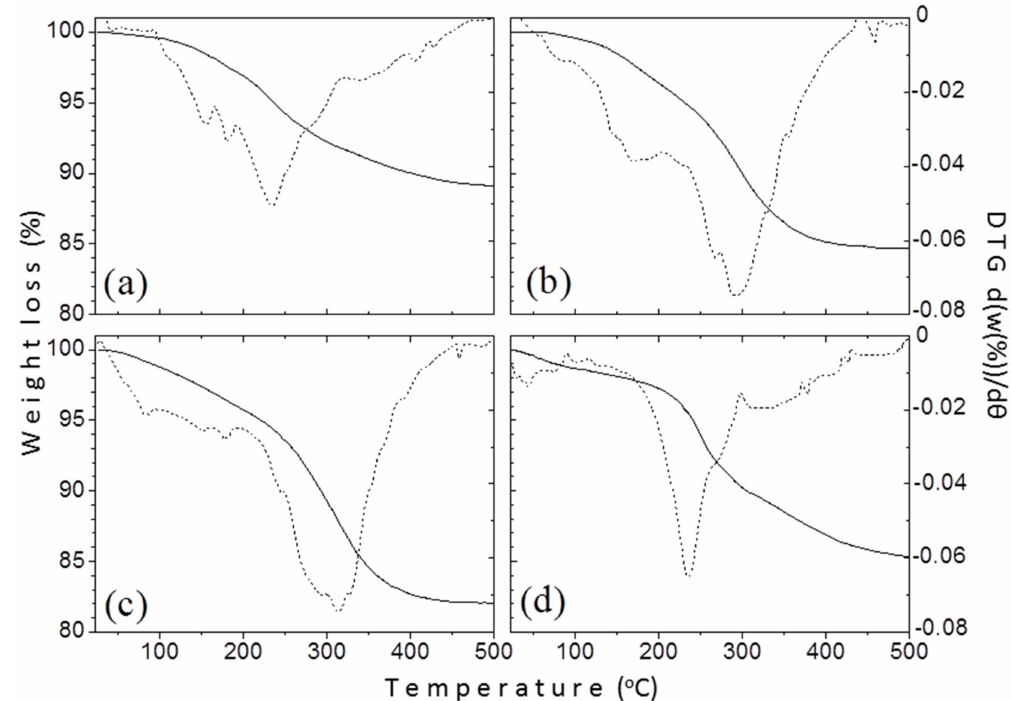
Figure 6. Thermogravimetric analysis (TGA) measurements for the samples: ( a ) TD1, ( b ) TD2, ( c ) TD3, and ( d ) TD4. The continuous line represents the % mass loss versus temperature, while the noncontinuous one the derivative of the mass loss versus temperature.